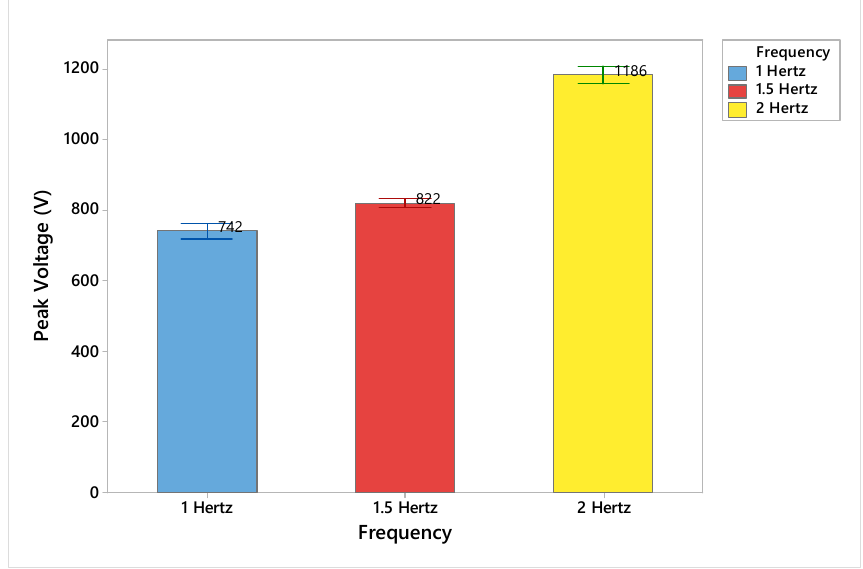
Figure 5. Effect of different frequency (Hertz) on the electrostatic charge generation.